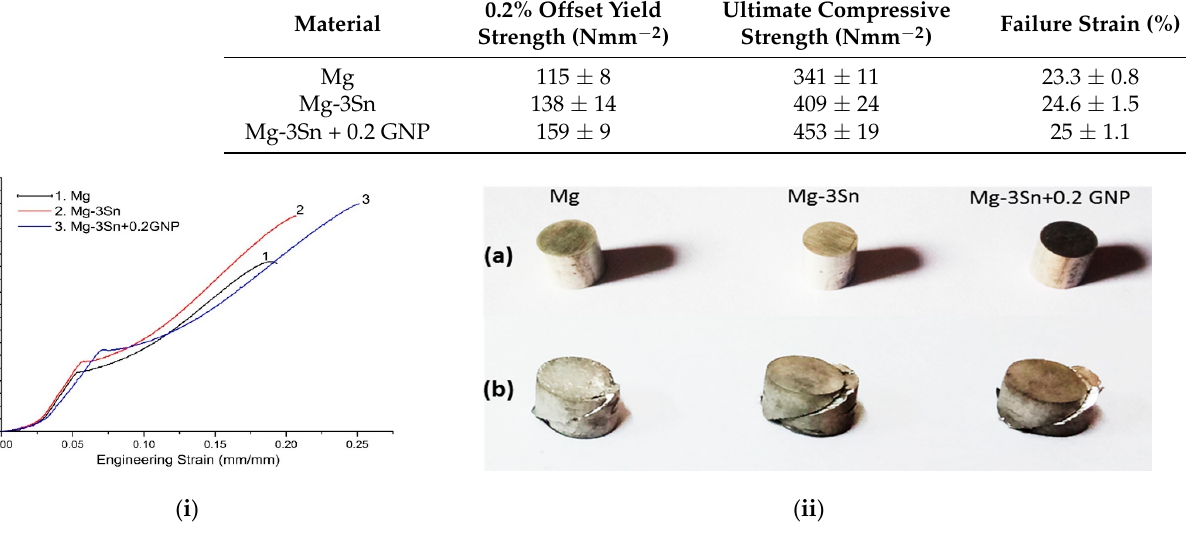
Table 3. Compressive properties at room temperature (24 °C).